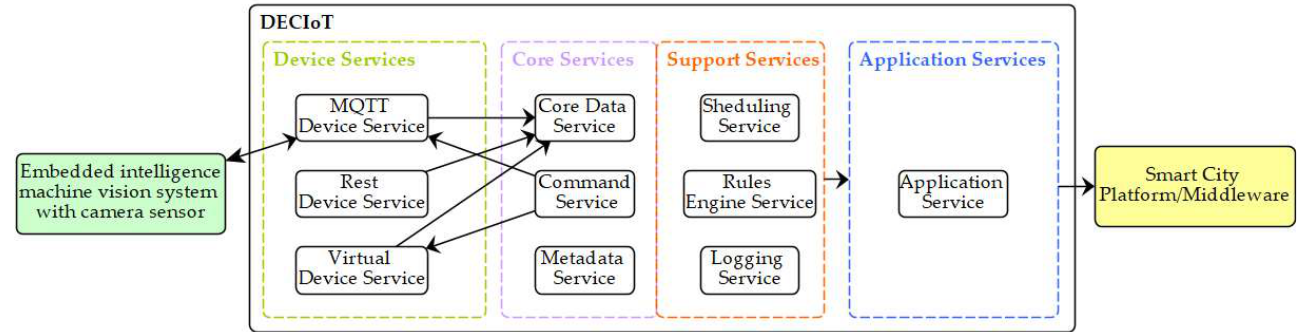
Figure 1. DECIoT architecture. The four main different layers of the proposed edge computing framework. From left to right: (i) the Device Service Layer acts as an interface of the system with physical devices and is tasked with the functionality of collecting data and actuating the devices with command; (ii) the Core Services Layer is used for storing data, commanding and registering devices; (iii) the Support Services Layer includes microservices for local/edge analytics and typical application duties, such as logging, scheduling, and data filtering; (iv) the Application Services Layer consists of one or more microservices to extract, transform, and send data from the previous layer to other endpoints or applications.